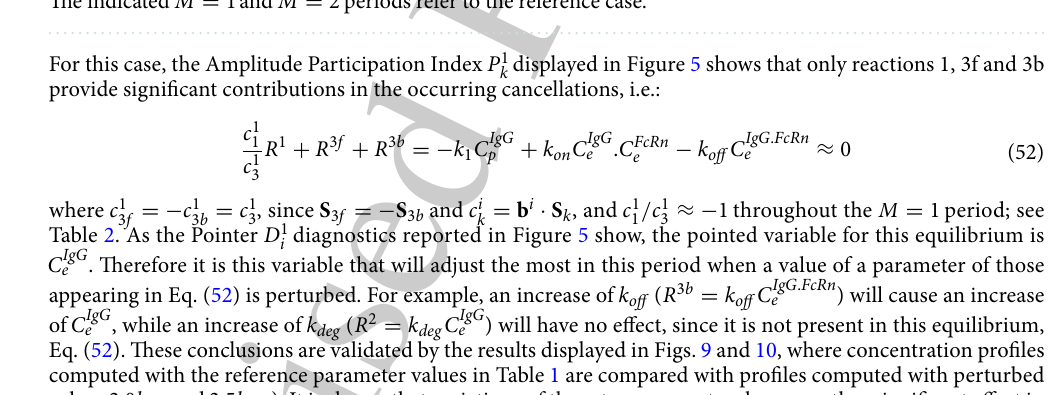
Figure 10. The reference (solid, k deg ) and the perturbed (dashed, 2.5 k deg ) concentration and time scale profiles. The indicated M = 1 and M = 2 periods refer to the reference